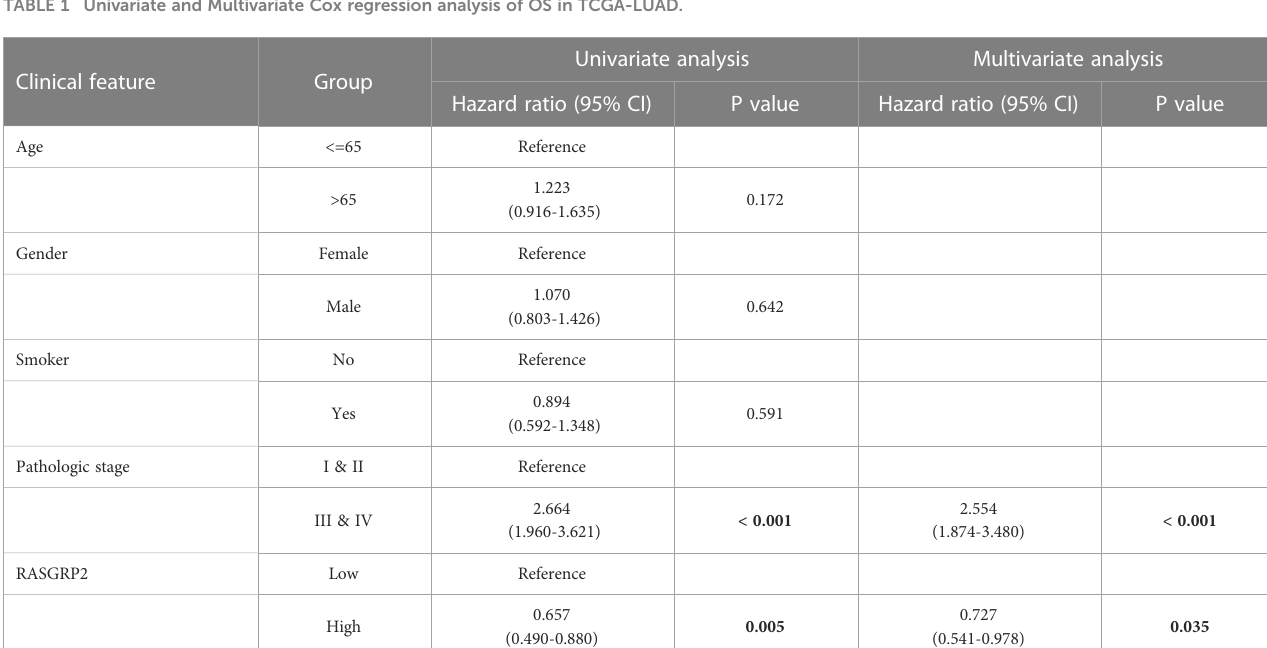
Univariate analysis Multivariate